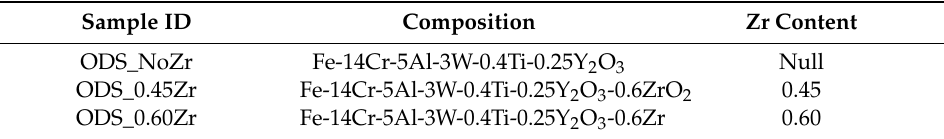
Table 1. Nominal composition and Zr content of ODS powders